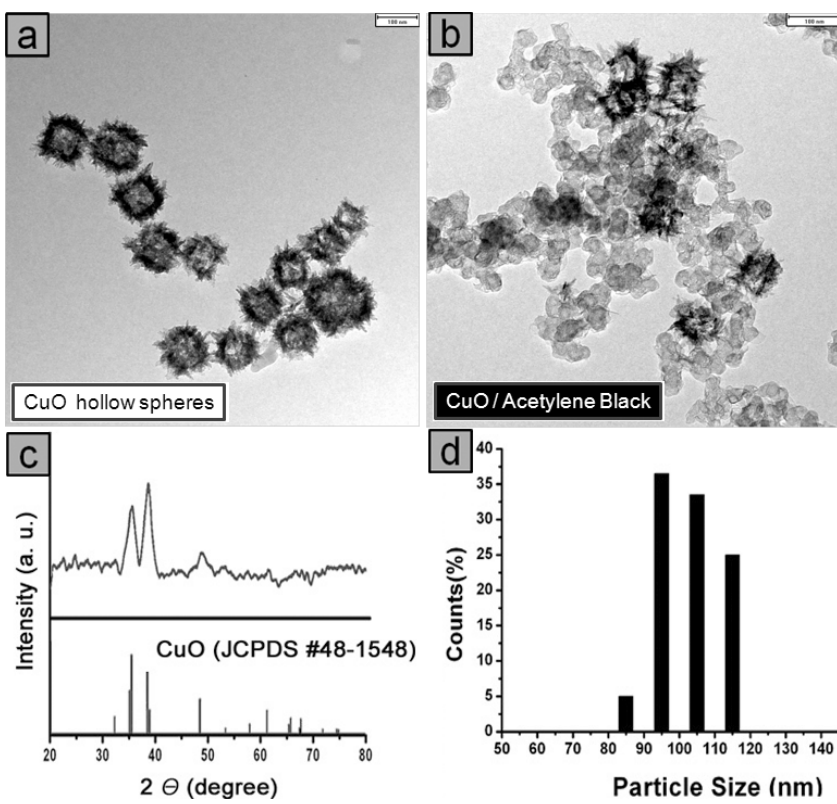
Figure 1 . (a) TEM image, c) XRD pattern, d) size distribution diagrams of the CuO hollow nanospheres, and (b) TEM image of the CuO hollow nanospheres on acetylene black (CuO/AB). The scale bars represent 100